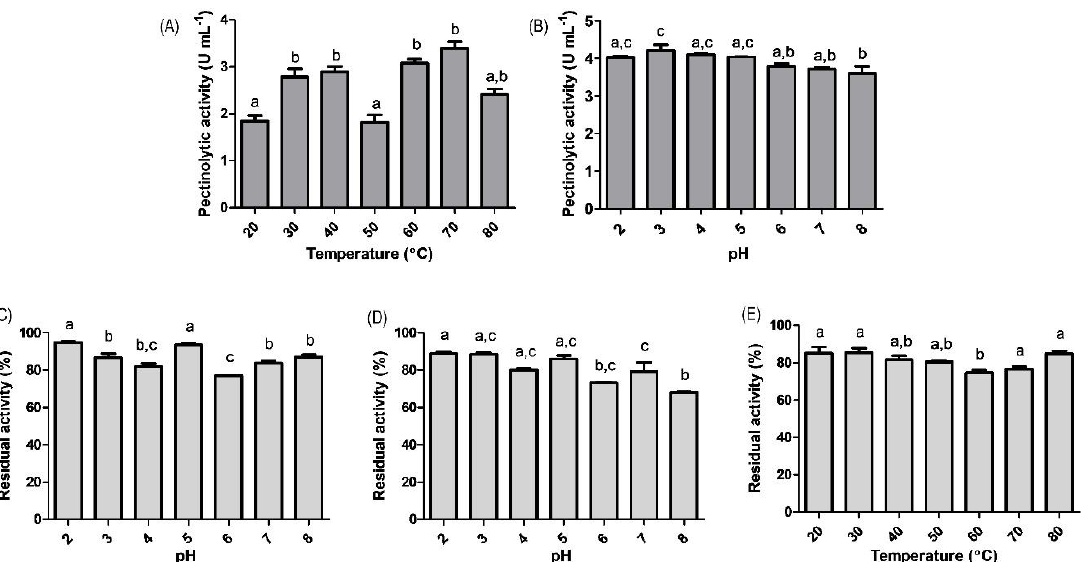
Figure 3. Influence of ( A ) pH and ( B ) temperature in the activity and in the stability after ( C ) 1 h and ( D ) 12 h pH treatment and ( E ) 1 h temperature treatment of the crude pectinolytic extract. Lowercase letters indicate significant differences between treatments ( p < 0.05).